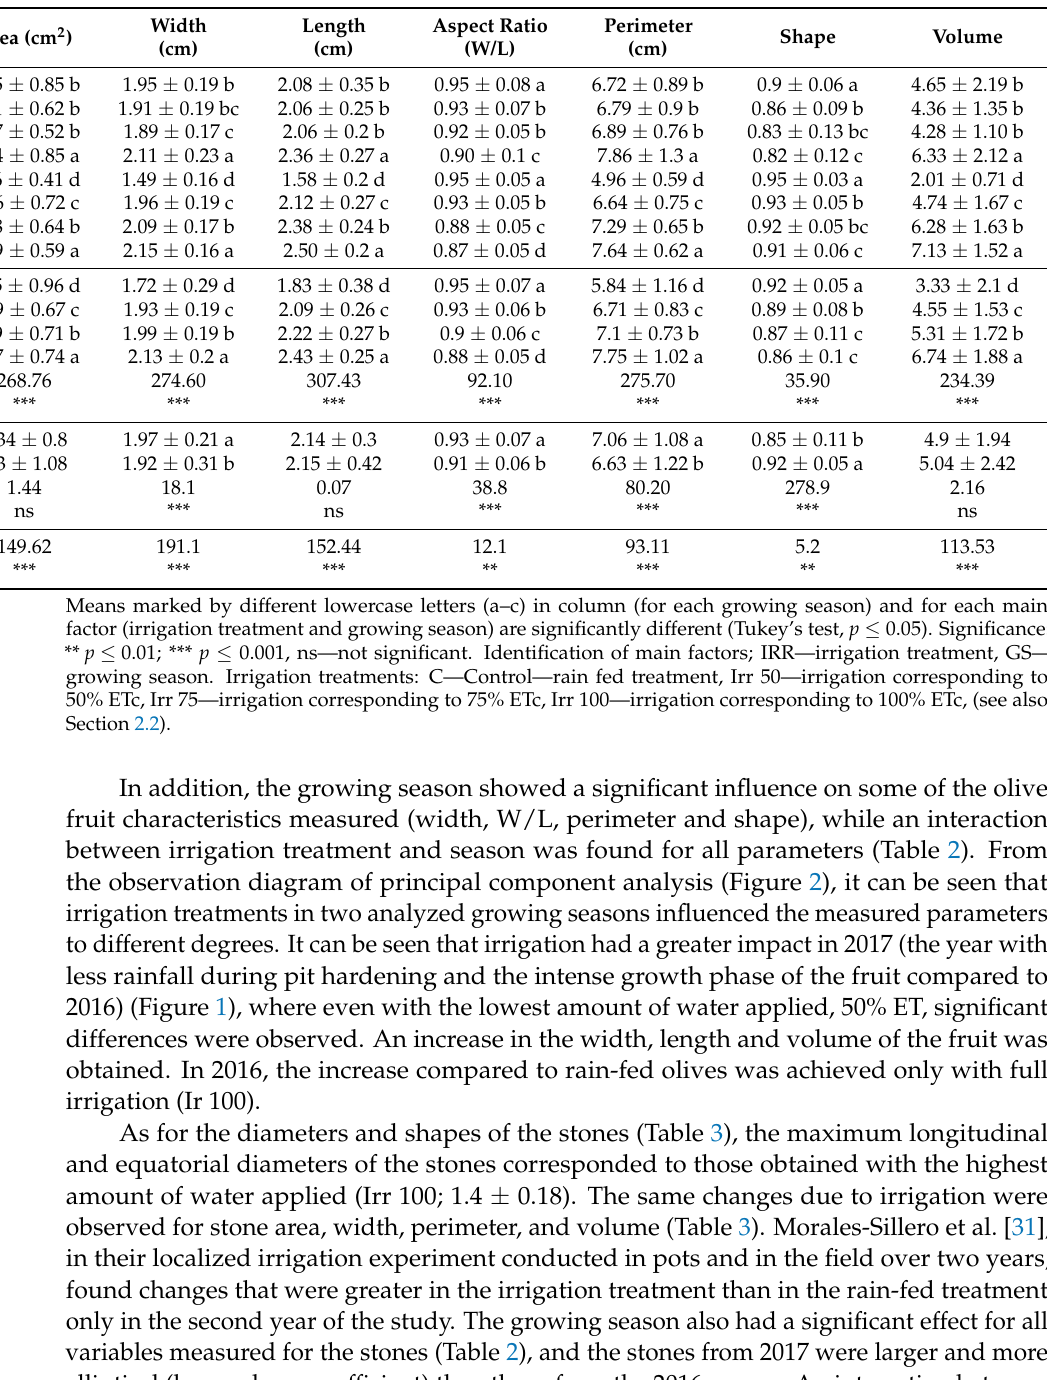
Table 2. Effect of different irrigation levels on olive fruit parameters during two experimental